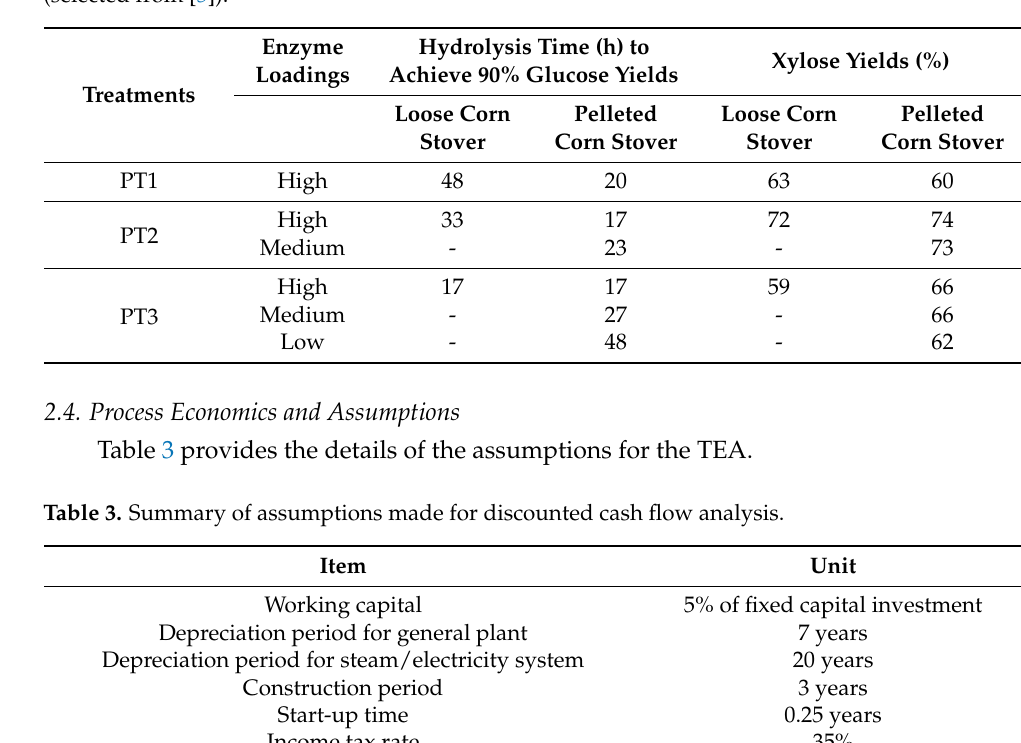
Table 2. Hydrolysis conditions used in this analysis for loose and pelleted forms of biomass scenarios (selected from [5]).